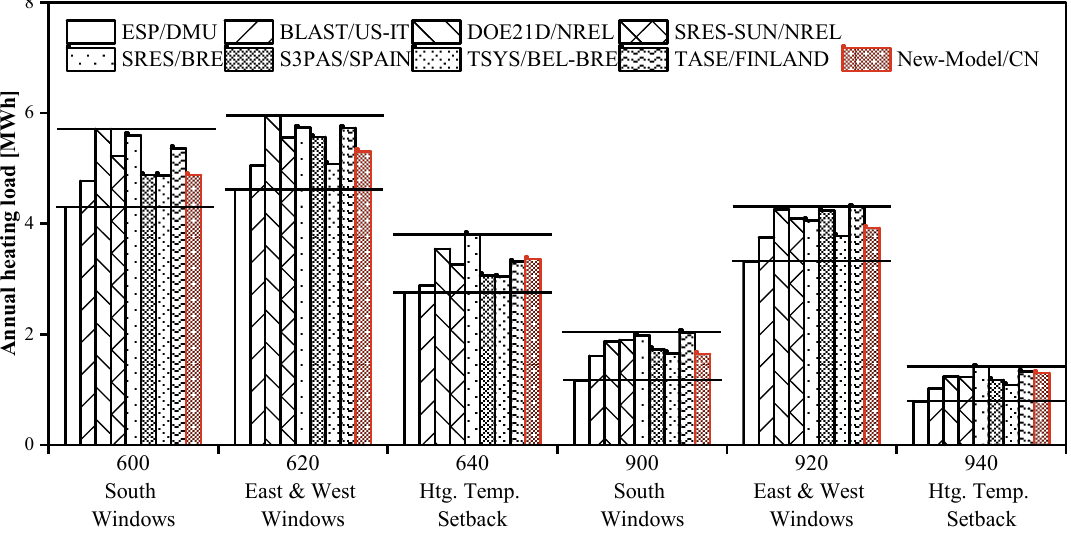
Figure 4. Annual heating load for low-mass 600-series and high-mass 900-series.